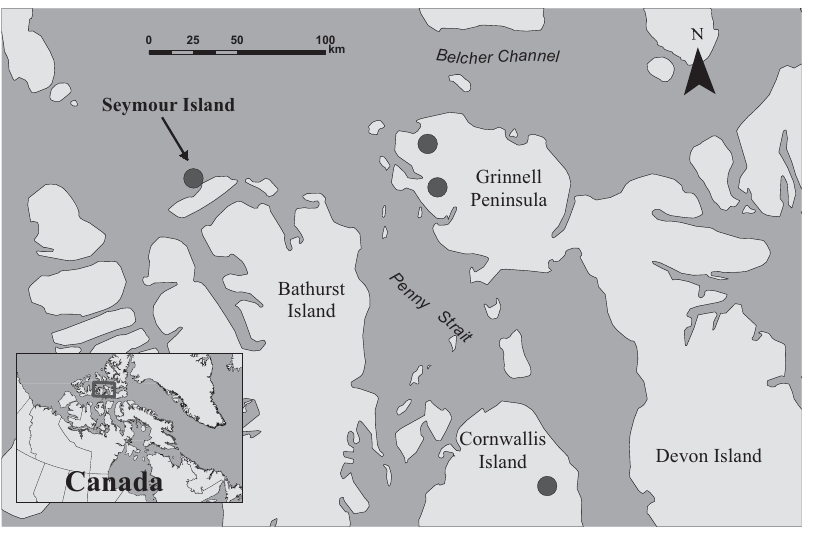
Fig. 4. Breeding colonies used in 2011 and 2013 by ivory gulls. In 2011, one was located on Seymour Island, at the long-known colony site (both gulls abandoned in incubation) and two newly found colonies were located on Grinnell Peninsula (one ivory gull at each colony). In 2013, one ivory gull was located on Cornwallis Island, but transmissions ceased shortly after its